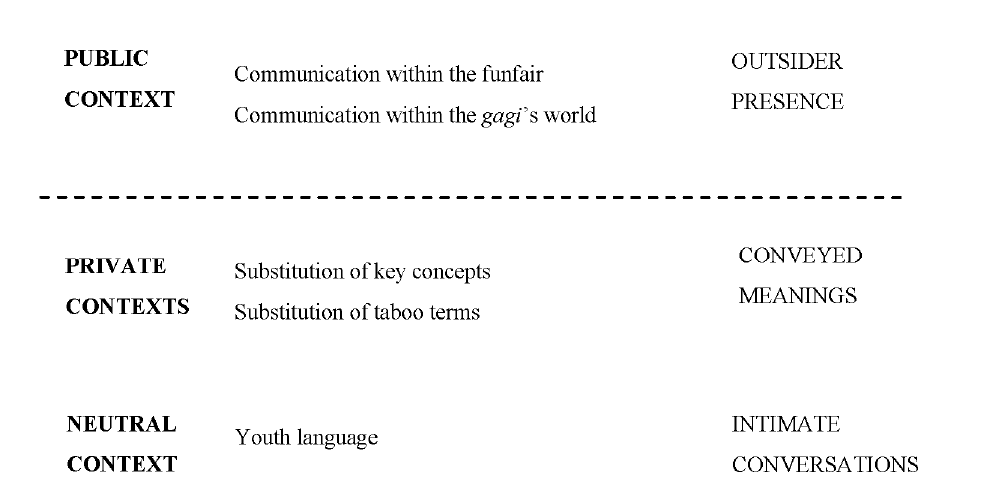
Figure 2. Contexts of use of Neodritto.